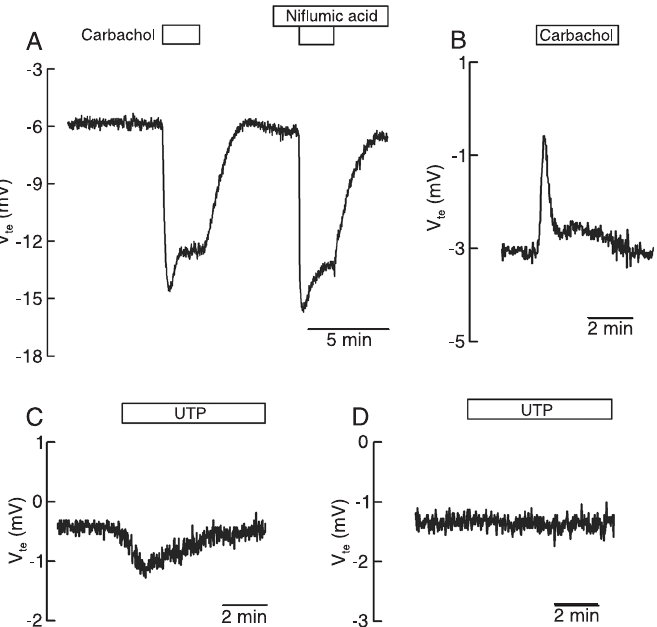
Figure 1. Calcium-activated chloride secretion in mouse colon. The traces show continuous recordings of transepithelial potential difference (V te ) taken from stripped tissues mounted in Ussing chambers under current-clamp conditions. A change in V te in the negative direction corresponds to anion secretion, while positive shifts in V te are consistent with cation (generally po- tassium) secretion (21). A , Addition of basolateral carbachol (100 µM) to the colon of a wild-type mouse reveals a robust chloride secretion response. The effect was not inhibited by the calcium-activated chloride channel blocker niflumic acid added to the apical side of the tissue at a concentration of 150 µM. When colon epithelium from a mouse deficient in cystic fibrosis trans - membrane conductance regulator (CFTR) (58) was similarly challenged with carbachol there was no response that could be linked to chloride secretion.